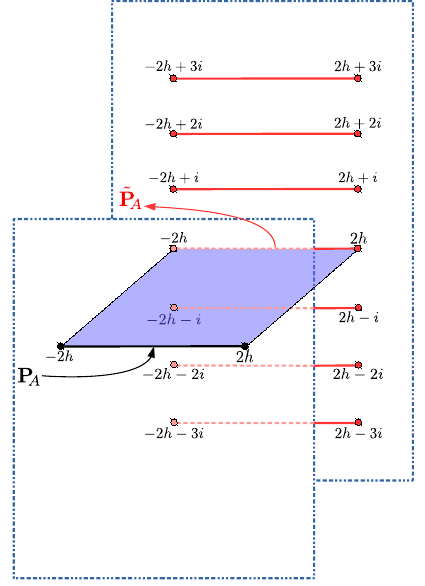
Figure 2 . The quasi-periodicity property of (cid:23) a functions on a sheet with long cuts corresponds to (cid:23) a ( u + i ) = e (cid:0) i P (cid:23) a ( u ) on the de(cid:12)ning sheet with short cuts. e